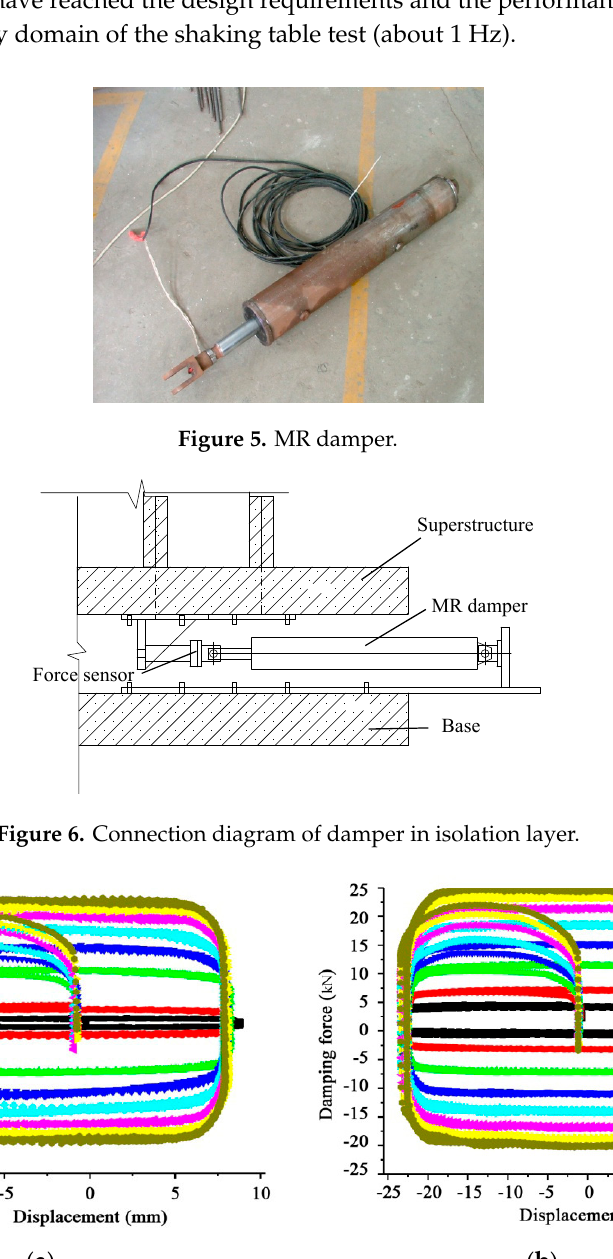
Figure 7. The hysteretic curve under ( a ) an amplitude of 10 mm and 1-Hz sine wave, and ( b ) an amplitude of 20 mm and 0.5 Hz sine wave.